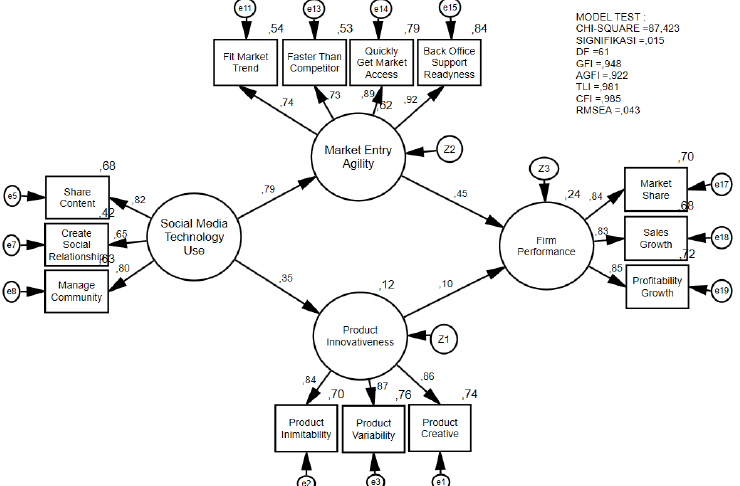
Fig. 1. Structural Equation Model Testing